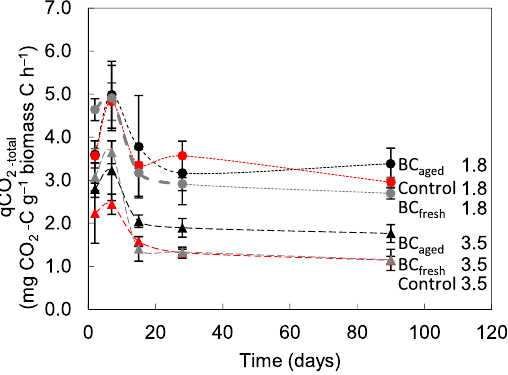
Figure 4. Metabolic quotient (qCO 2 ) during the incubation experiment. Every data point represents a mean value of three replicates with standard